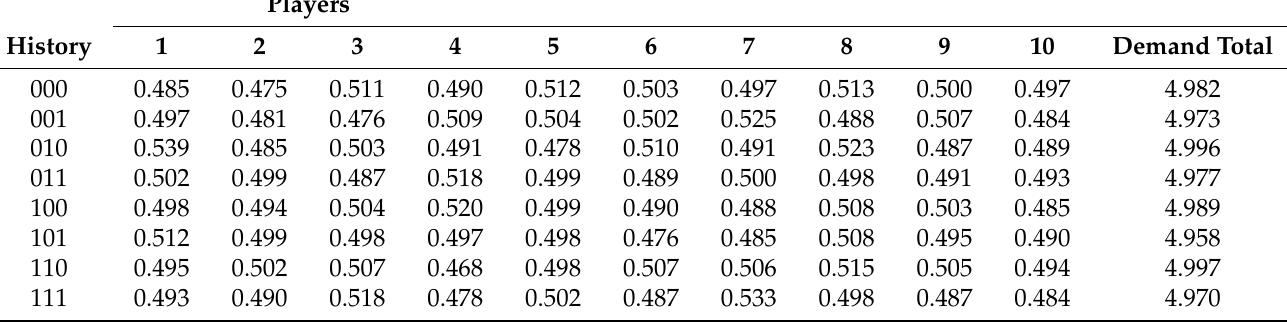
Table 5. demands at generation